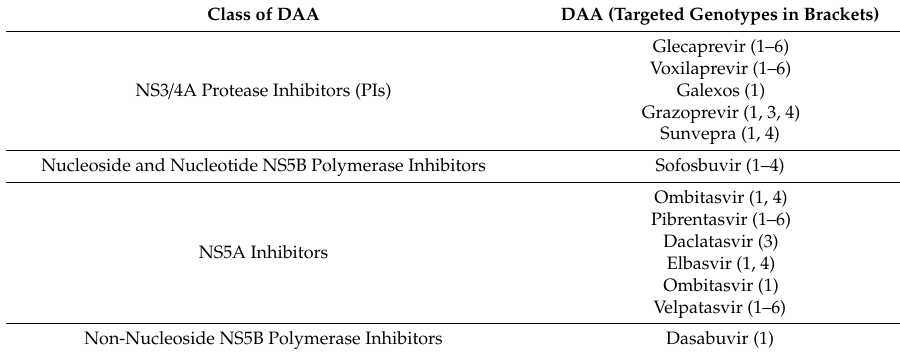
Table 1. The four classes of direct acting antivirals (DAAs) that are being used in di ff erent combinations and that form the mainstay of anti-HCV